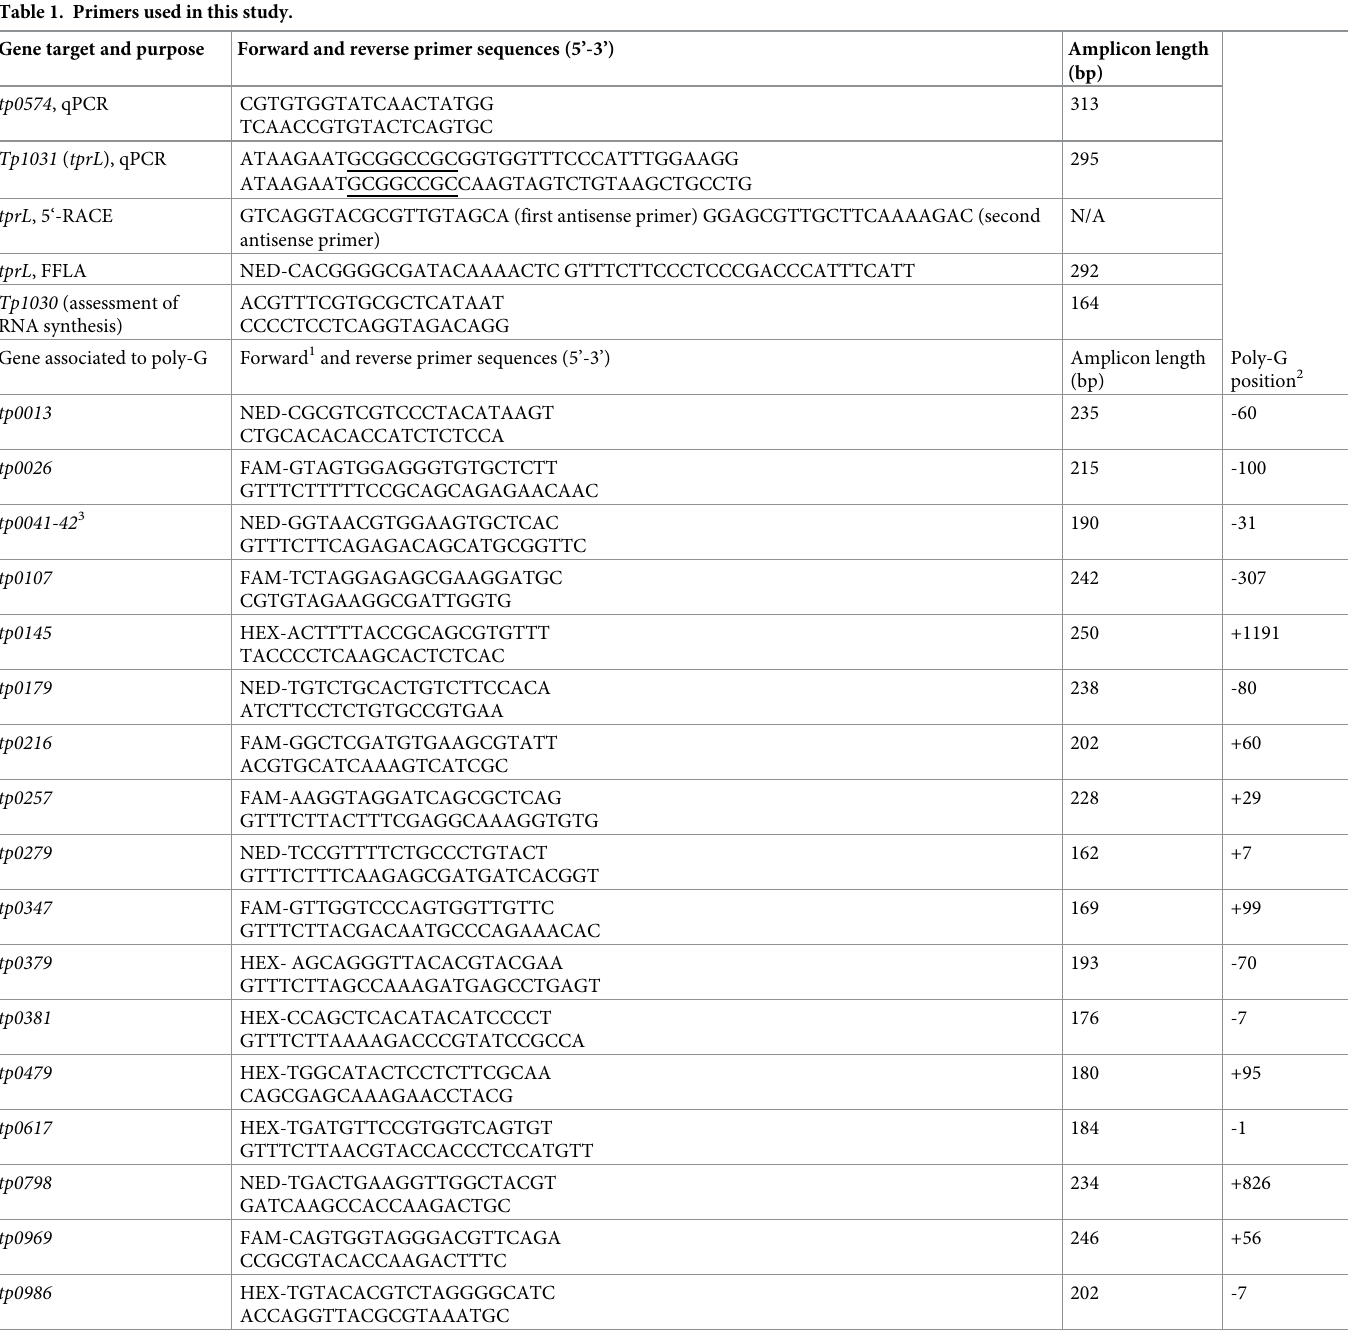
Table 1. Primers used in this study. Gene target and